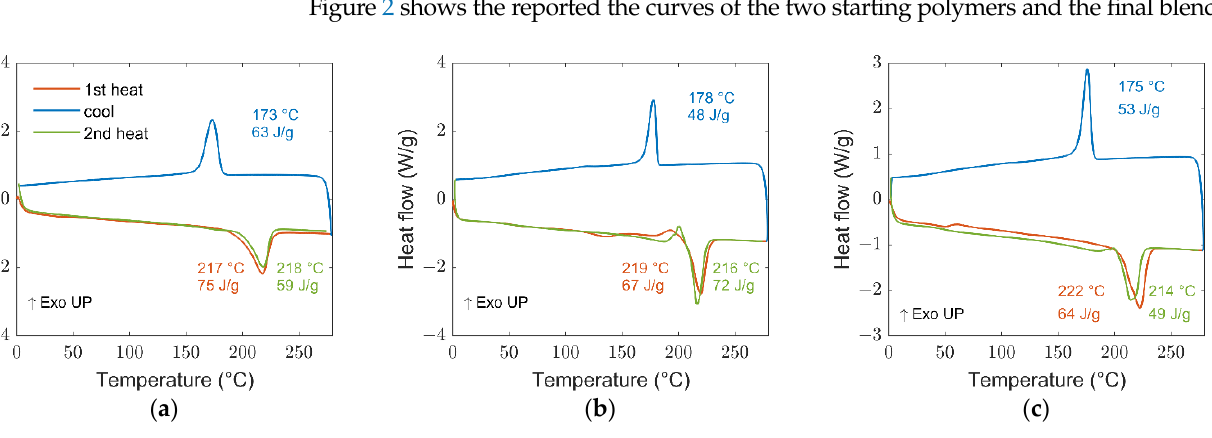
Figure 2. DSC curves of PA6 ( a ), PA6.9 ( b ) and blended polymer of 40% PA6.9, 60% PA6 ( c